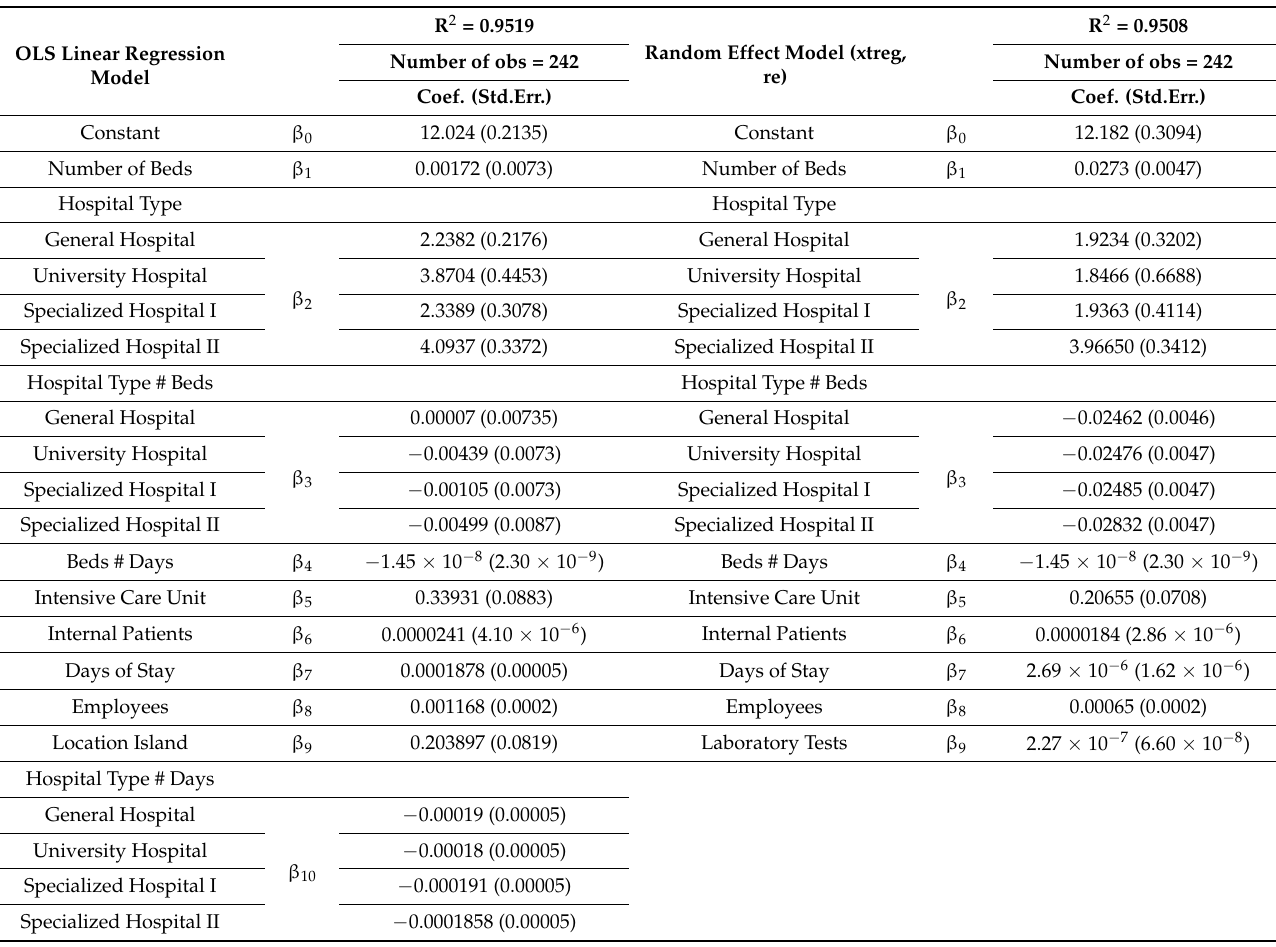
Table 3. Analytical results from the regression analysis of the total hospital operating costs (Logarithm of Total Costs